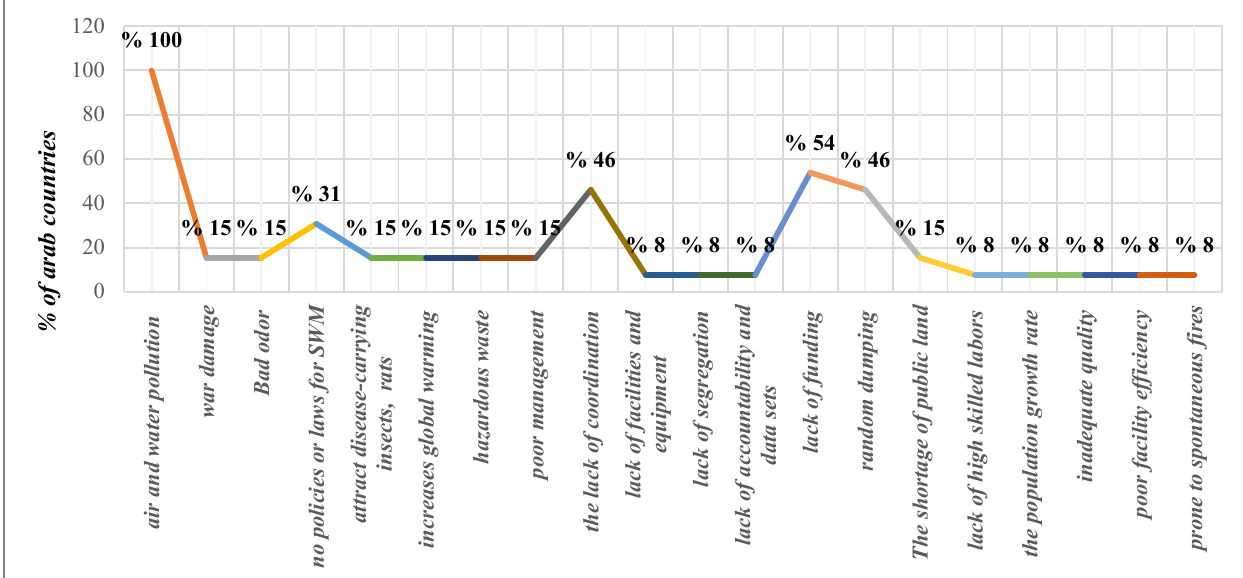
Figure 7. SWM ‐ related challenges faced by Arab countries as percentages.